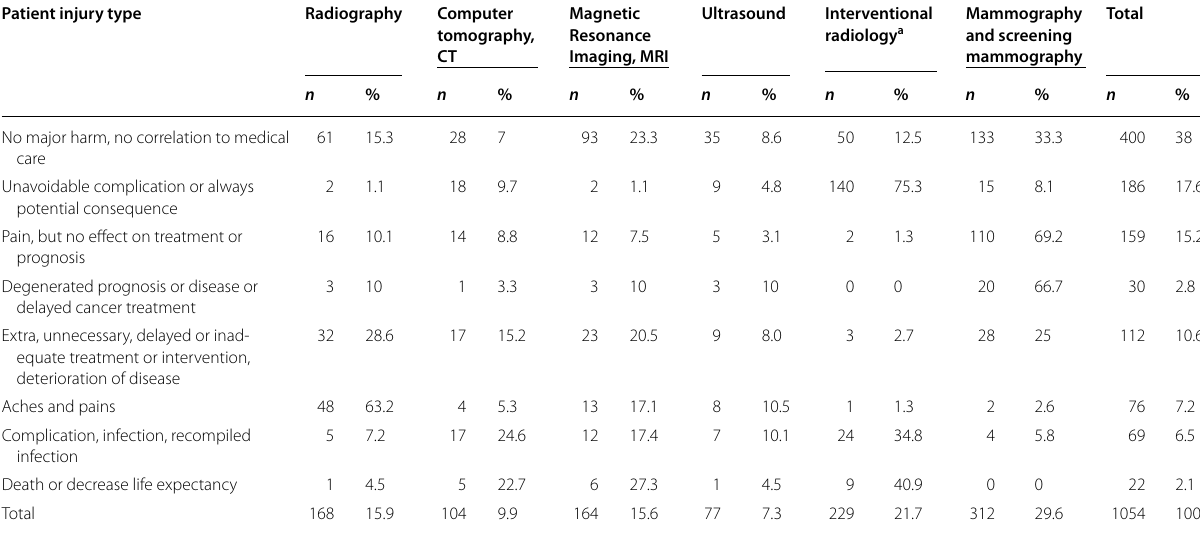
a Diagnostic interventional and vascular radiology and fluoroscopy examinations